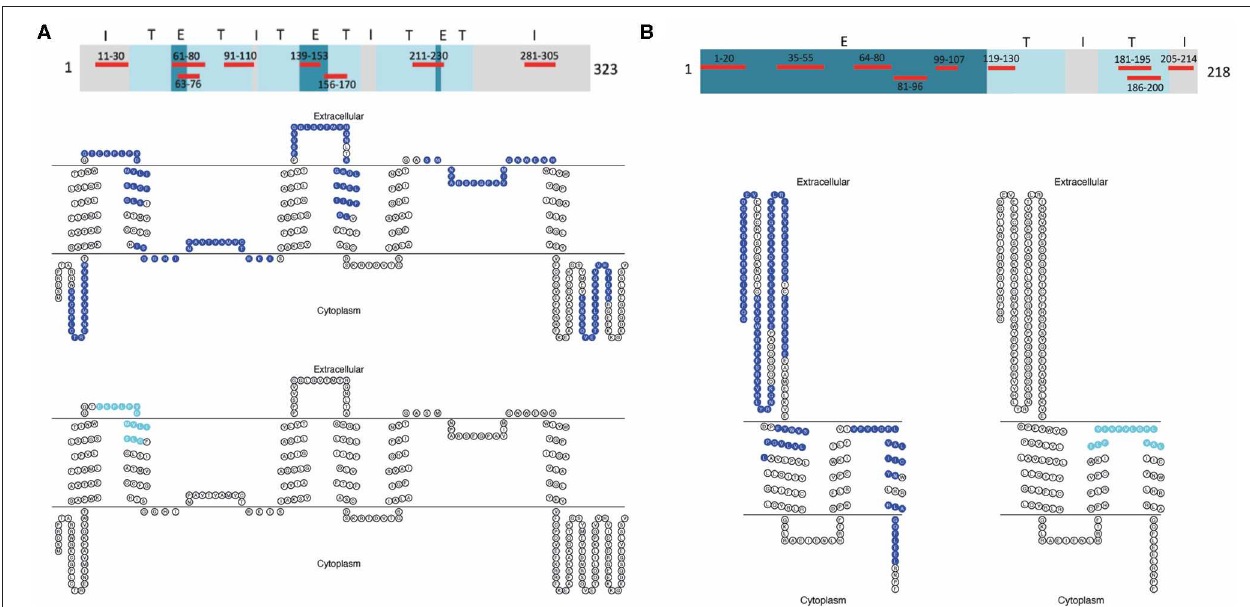
FIGURE 1 | AQP4 and MOG peptides used for CD4 + T-cell stimulation. (A) Topological map of the human AQP4 protein (323 aa). Eight selected AQP4 peptides corresponding to intracellular (I), extracellular (E), and transmembrane (T) sequences of human AQP4 used for CD4 + T-cell stimulation are highlighted in red. Below, seven AQP4 determinants (blue) and further down one overlapping AQP4 determinant (aqua) are represented within a human AQP4 topological diagram using TOPO2 transmembrane protein display software (http://www.sacs.ucsf.edu/TOPO2/). (B) Topological map of the human MOG protein (218 aa). Nine selected MOG peptides corresponding to intracellular (I), extracellular (E), and transmembrane (T) sequences of human MOG used for CD4 + T-cell stimulation are highlighted in red. Below on the left, eight MOG determinants (blue) and on the right, one overlapping MOG determinant (aqua) are represented within a human MOG topological diagram using TOPO2 transmembrane protein display software (http://www.sacs.ucsf.edu/TOPO2/). AQP4, aquaporin-4; MOG, myelin oligodendrocyte